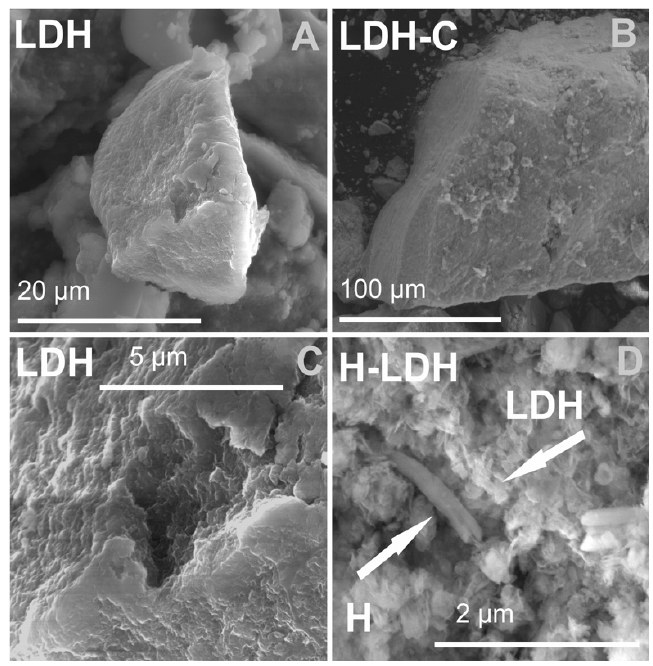
Figure 3. SEM images of the synthesized materials: ( A ) and ( C ) LDH, ( B ) LDH-C, and ( D ) H-LDH.